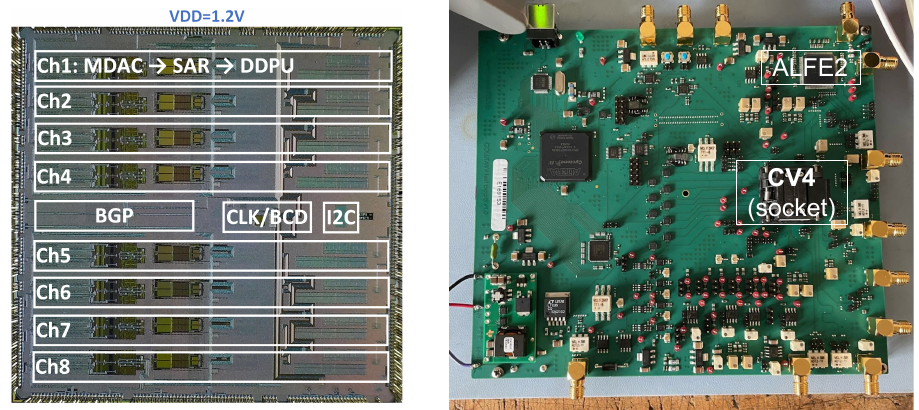
Fig. 1: CV4 in the context of the LAr readout system. Photograph Figure 4. Die image of the ADC CV4 pre-prototype ASIC with key circuit elements outlined ( left ), of the 5.5mm x 5.8mm 8-channel 65 nm CMOS ADC die wirebonded and the corresponding CV4 testboard with socketed chip ( right ). to a 100-pin QFN package. Connections to only two ADC channels are depicted.